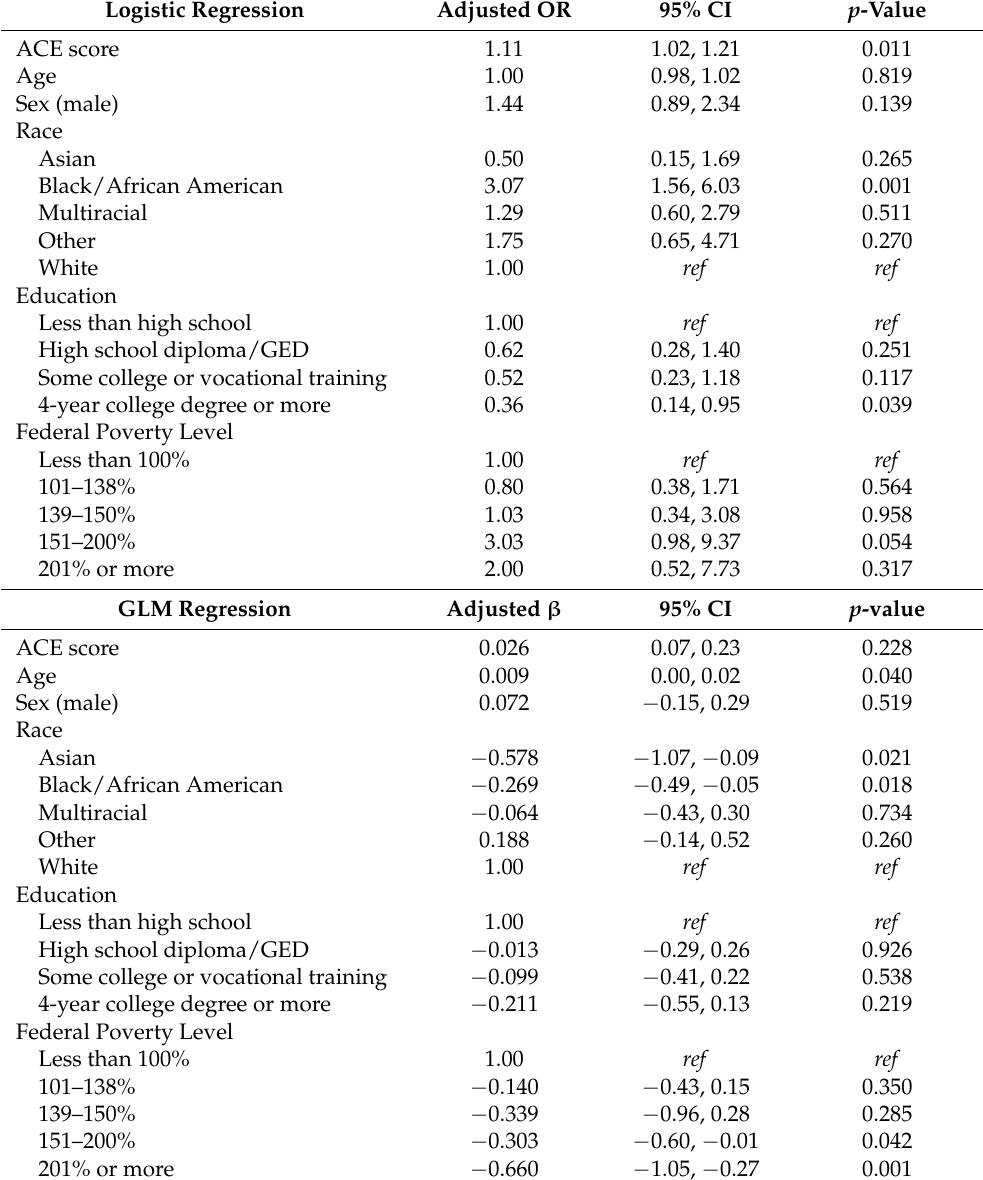
Table 2. Two-part model of associations between ACE score and ED utilization within 12 months of survey